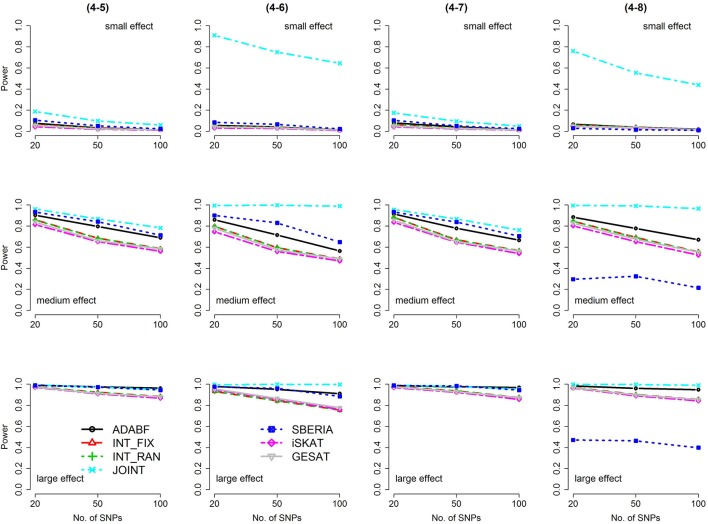
Power of the seven tests for binary traits (4 SNP × E, from Scenario 4-5 to 4-8). The x-axis represents the number of SNPs in the gene, whereas the y-axis depicts the power at the nominal significance level α = 2.5 × 10−6. From the top row to the bottom row, the magnitudes of SNP main effects and SNP × E interaction effects were evaluated at three levels: small, medium, and large, respectively.